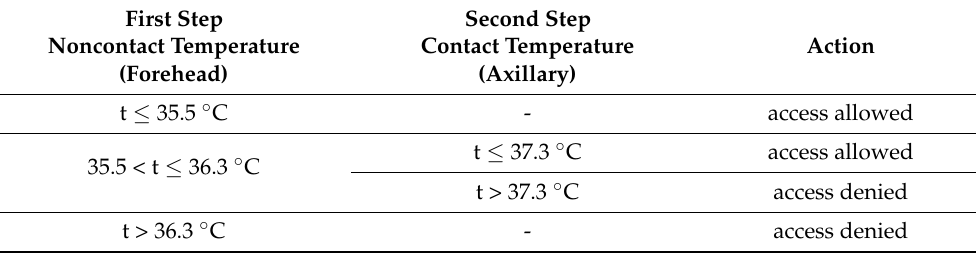
Table 3. Example of the proposed temperature screening protocol in indoor